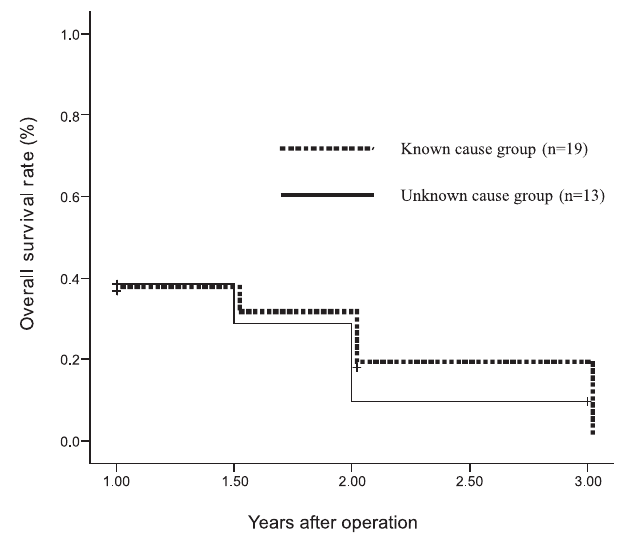
Figure 1 - Comparison of survival among patients with abnormal postopera- tive serum CEA levels